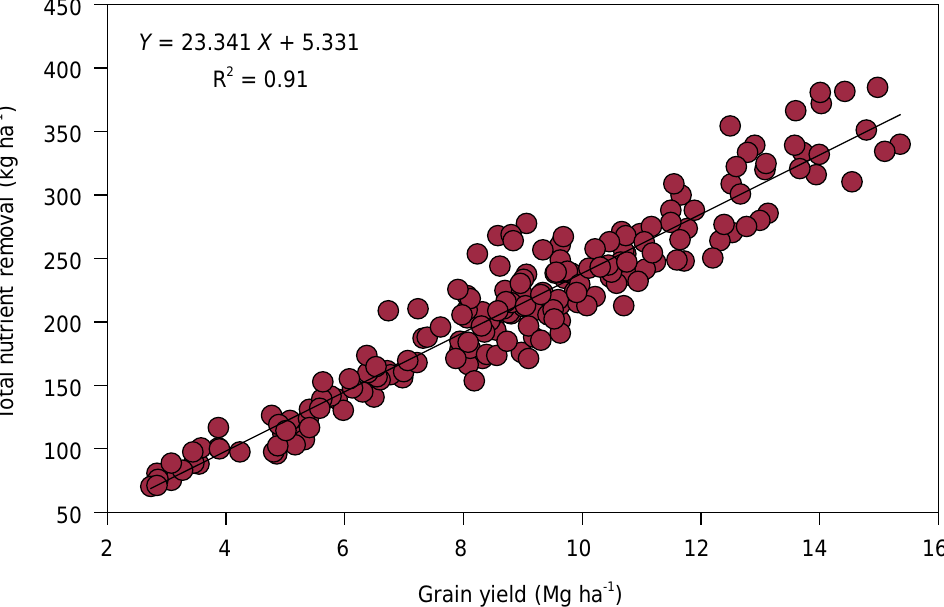
Figure 1. Total nutrient removal in grains (N, P, K, Ca, Mg, S, Fe, Mn, Cu, Zn, and B) related to corn grain yield.